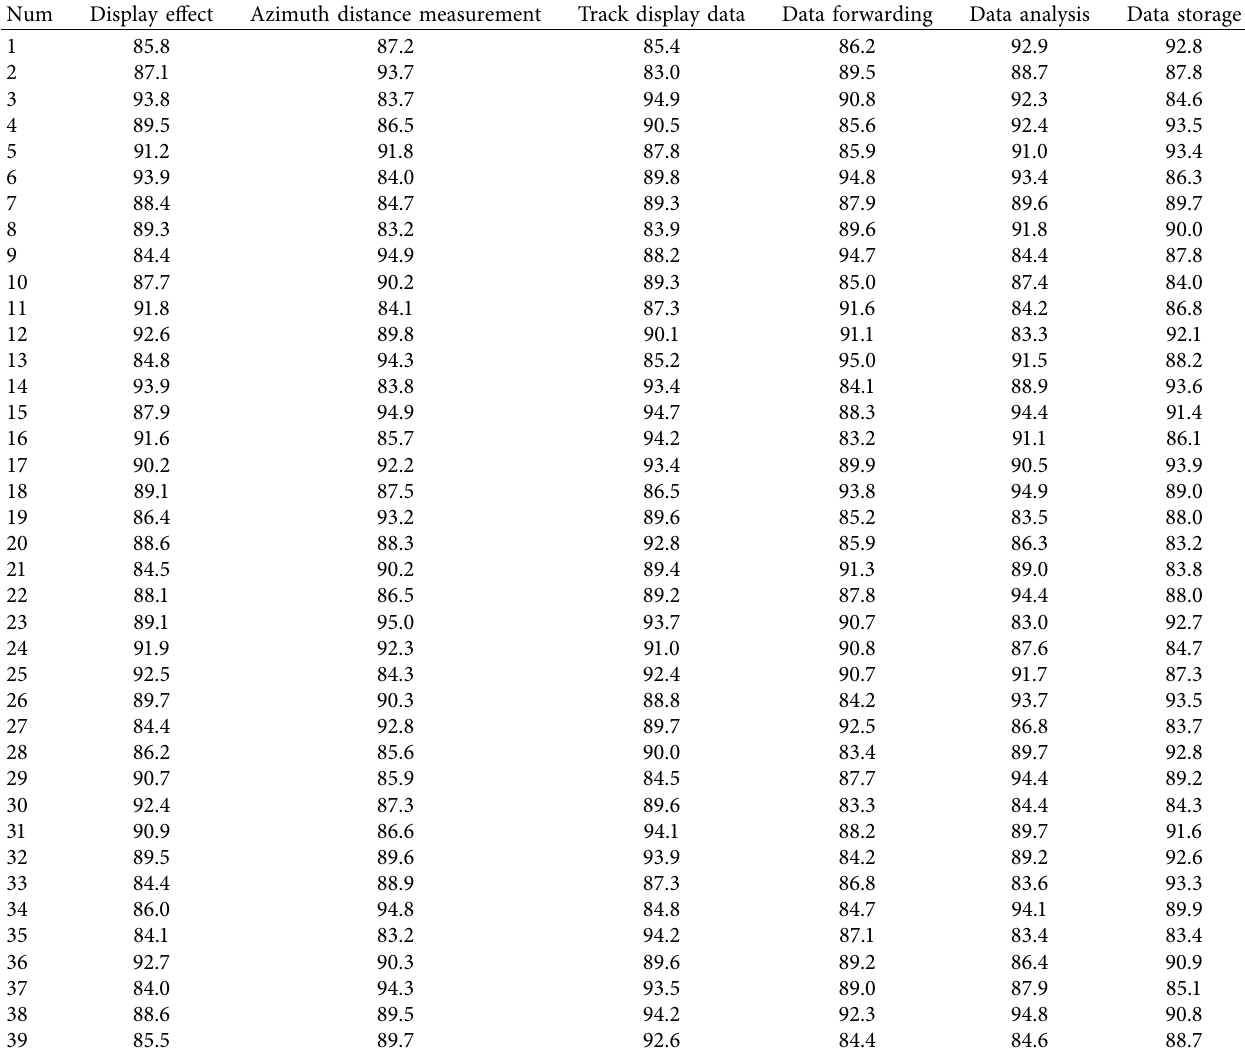
Table 1: Statistical table of the score of the data processing effect of the channel optimization system of the ABS-B aviation target surveillance radar based on the improved filtering algorithm. Num Display